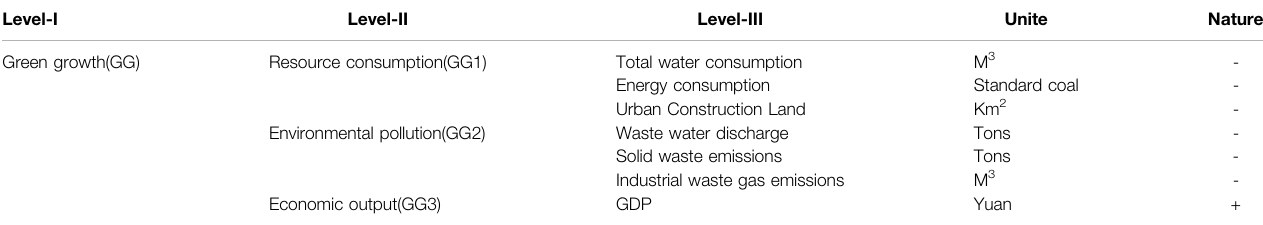
TABLE 2 | The composition of Green growth (GG).